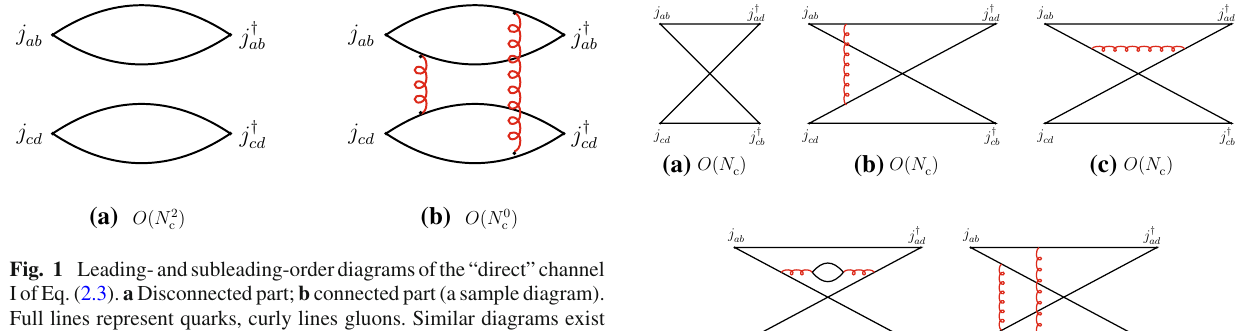
Next, we consider the recombination channel of